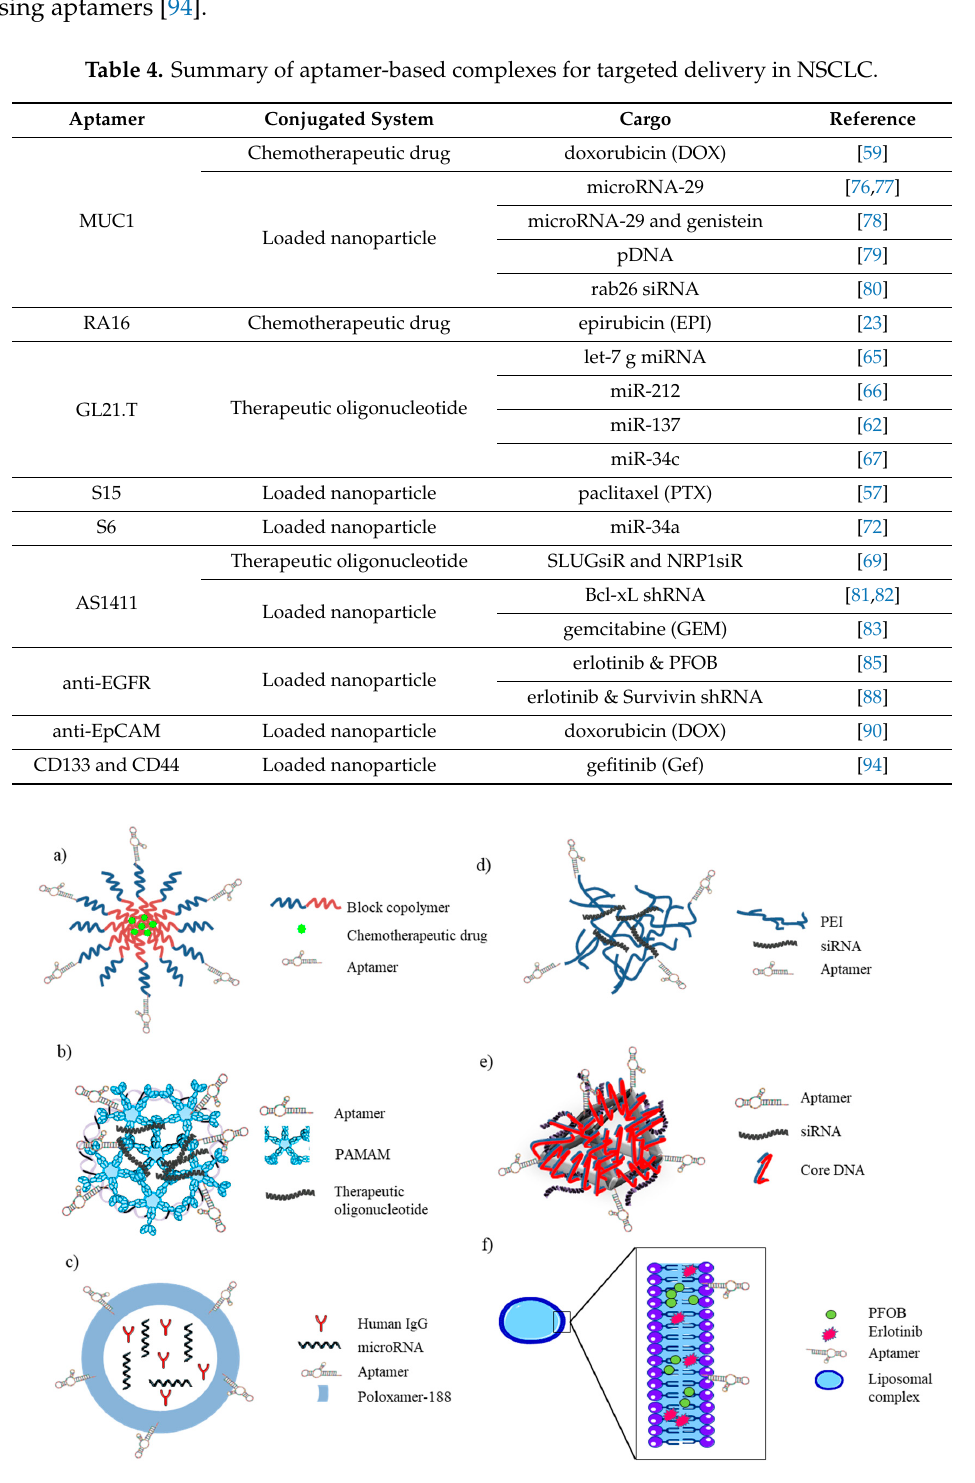
Figure 5. Schematic representation of aptamer–nanomaterial conjugated systems. ( a ) Aptamer– block copolymer; ( b ) aptamer–dendritic structure; ( c ) aptamer–poloxamer; ( d )